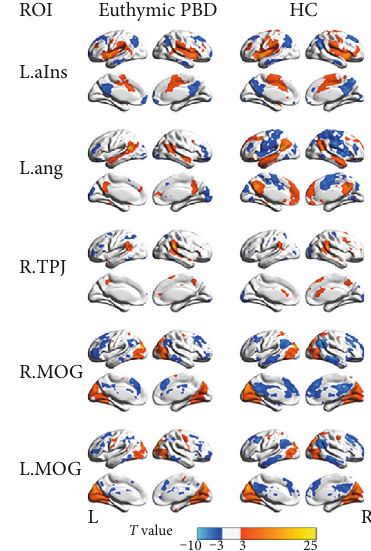
Figure 3: The group-level functional connectivity maps seeded at 5 ROIs in the euthymic pediatric bipolar disorder (PBD) and healthy control (HC) groups (one-sample t -test, P < 0 : 05 , FDR corrected, cluster size > 621mm 3 ). L: left; R: right. ROIs ’ abbreviations are consistent with those shown in Table